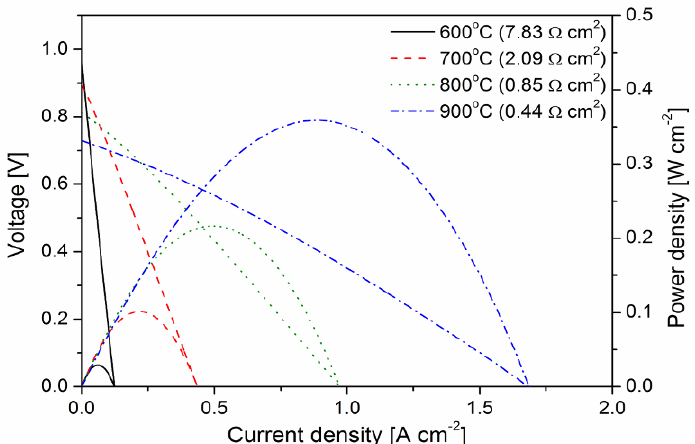
Figure 12. Voltage and power density as a function of current density of solid oxide fuel cell supported on Ce Numbers in brackets denote total cell